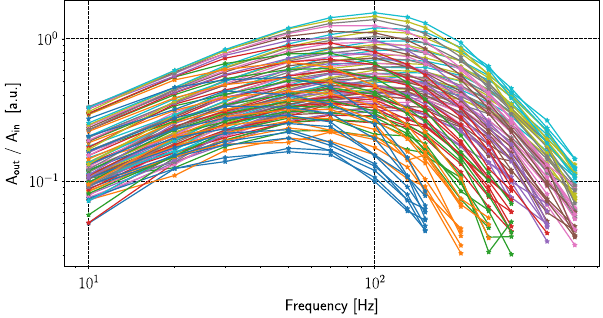
FIG. 16. Overview of all the obtained transfer functions from the V × ξ parameter scan, in the range from 1 = 2 to 2 times the ss nominal